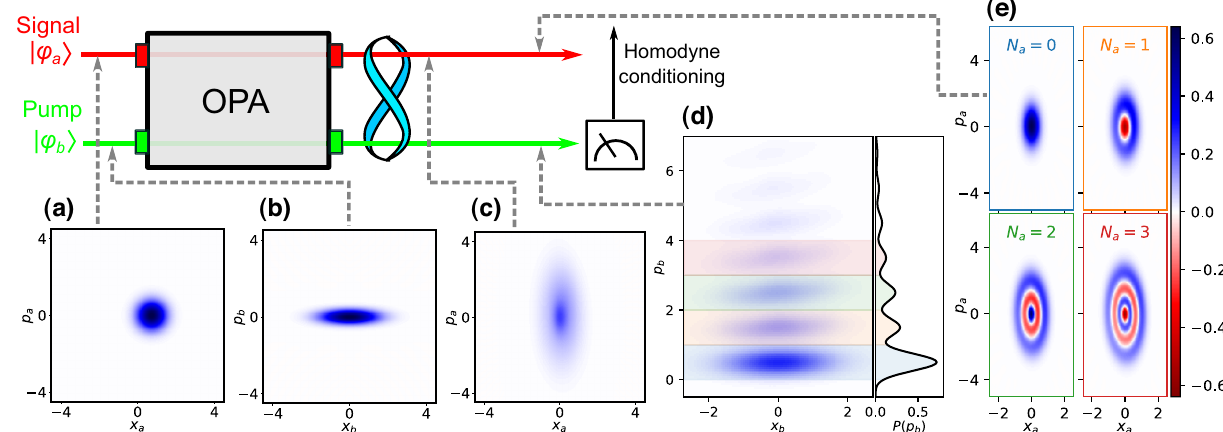
FIG. 1. Our PNR QND measurement scheme using nonlinear quantum behavior of an OPA, where the phase-space representation (i.e., Wigner functions) of the system state at each step of the protocol is shown using numerical data. For the numerical simulation, we consider an initial coherent signal state | ϕ a ( 0 ) (cid:5) = | α = 0.7 (cid:5) [shown in (a)], and we assume a p -squeezed vacuum state with width w = 1 / 4 as an initial pump state [shown in (b)]. The signal and pump states interact through a frequency-detuned OPA, whose dynamics induce conditional p displacements of the pump field depending on the number of signal Bogoliubov excitations ˆ N a . Concurrently, the OPA dynamics also cause conditional rotations on the signal Bogoliubov excitation depending on ˆ x b , leading to the phase spread of the final unconditional signal state [shown in (c)]. A complete p -homodyne measurement on the final pump state acts as a QND measurement of ˆ N a and projects the signal mode on a squeezed photon-number state, which is an eigenstate of ˆ N a . (d) The final pump state shown with the p -quadrature distribution P ( p b ) . (e) Ensemble-averaged signal states conditioned on the outcome of the homodyne measurement within an interval ˜ gt ( N a − 1 ) ≤ ˆ p b ≤ ˜ gt ( N a + 1 ) . We use the system parameters of (cid:9)/ g = 150 and ˜ g / g = 1, and the total interaction time of gt =